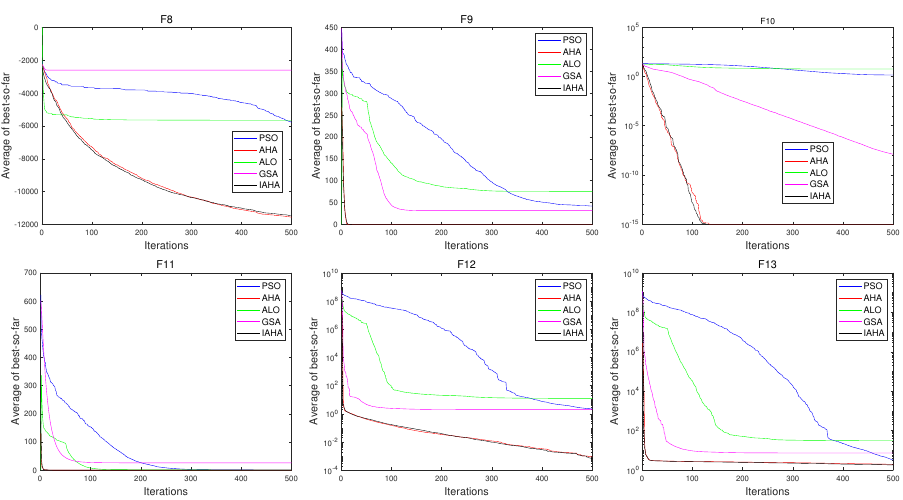
Figure 3. The average convergence curve of different optimization algorithms on high-dimensional multi-peak test function.